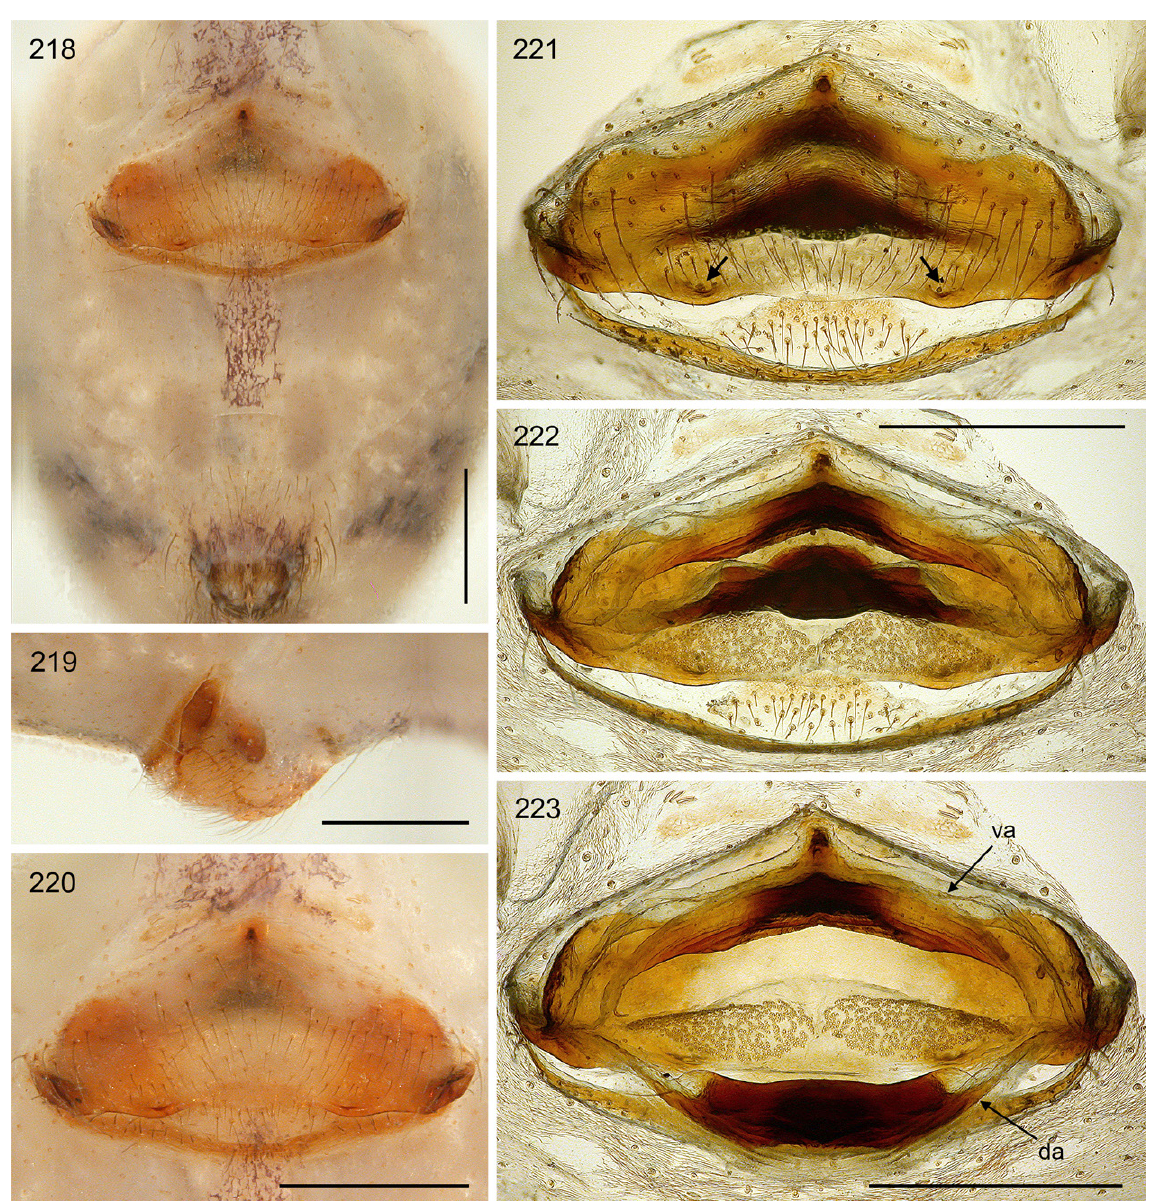
Figs 218–223. Maghreba saghro gen. et sp. nov.; female from Morocco, between Irherm and Tiferki (ZFMK Ar 22364). 218 . Abdomen, ventral view. 219–220 . Epigynum, lateral and ventral views. 221– 223 . Cleared female genitalia, ventral view, regular dorsal view, and dorsal view with dorsal arc tilted backwards; arrows: pockets (pits). Abbreviations: da = dorsal arc; va = ventral arc. Scale bars = 0.5